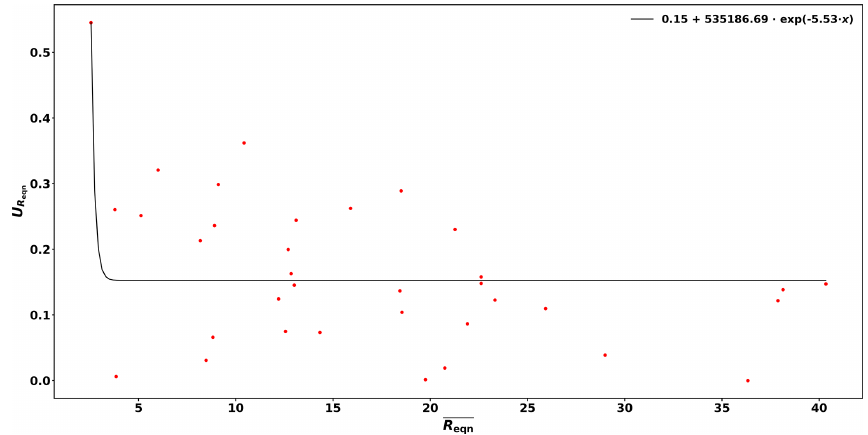
Figure B1. Uncertainty of R eqn ( U R ) as a function of R eqn . The solid line is the fit function for the precision of the measurements ( U prec ). eqn